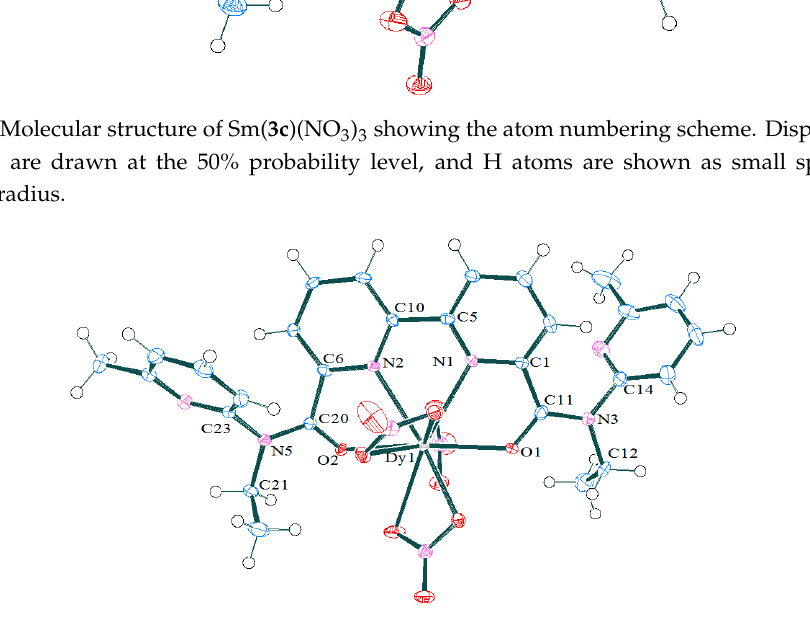
Figure 3. Molecular structure of Dy( 3c )(NO 3 ) 3 showing the atom numbering scheme. Two molecules represent isomers of the complex, found for two different crystals. Displacement ellipsoids are drawn at the 50% probability level, and H atoms are shown as small spheres of arbitrary radius. Table 3. Comparison of the interatomic distances (Å) and angles (°) in the coordination sphere of the metal ions for complexes of 3c with 2,2 ′ -bipyridyl-6,6 ′ -dicarboxylic acid (BPDA) ligand complexes. Bonds/Angles